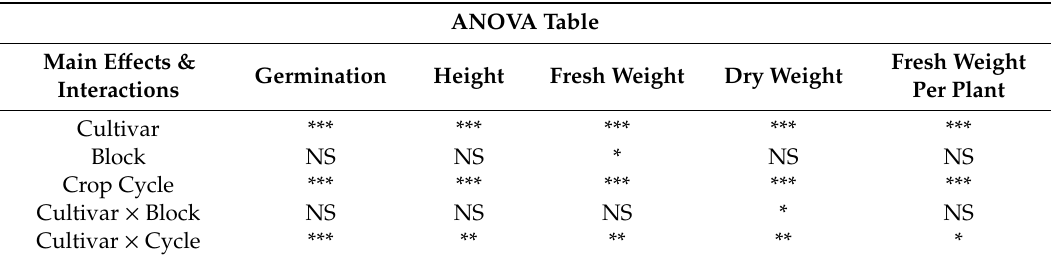
Table 3. Analysis of Variance on measured parameters for baby leaf hemp. ANOVA Table